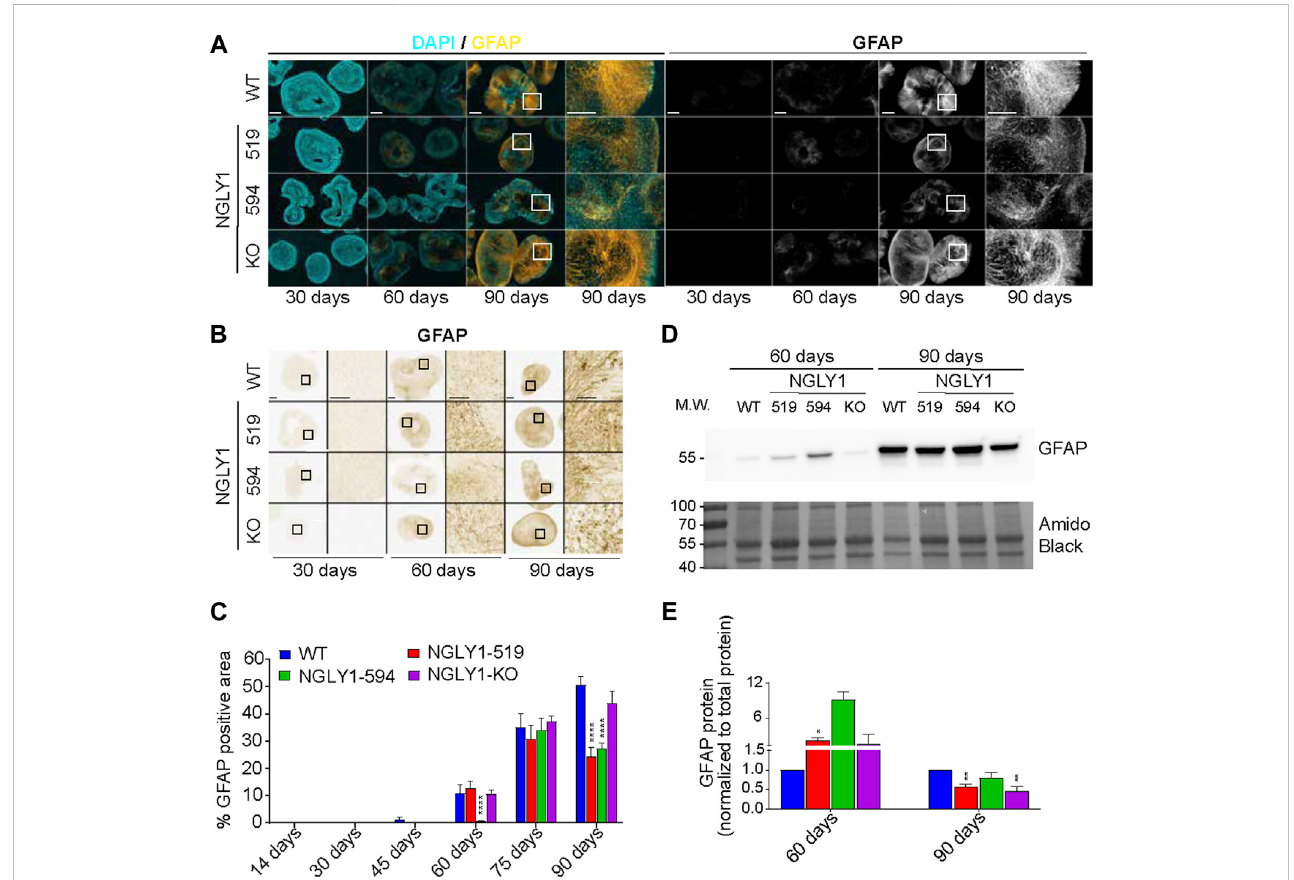
FIGURE 4 Development of astrocytes in midbrain organoids characterized by GFAP expression. (A) Representative immuno fl uorescence images at ×5 and ×20 magni fi cation showing DAPI (cyan) and GFAP (yellow). Scale bars: 250um (5x) and 50um (20x), white boxes indicate zoomed in region. (B) Representative bright fi eld images of GFAP immunohistochemistry staining at ×4 and ×20 magni fi cation. Scale bars:250um (4x) and 50um (20x), black boxes indicate zoomed in region. (C) Quanti fi cation of total percent positive GFAP staining. (D) A representative western blot showing GFAP expression in cell lysates obtained from control and NGLY1 disease midbrain organoids. (E) Quanti fi cation of GFAP protein expression normalized to total protein. Data representative of all slices derived from three midbrain organoids. Statistical signi fi cance determined bymultiple t -test analysis denoted by* = ( p ≤ 0.05), ** = ( p ≤ 0.01), *** = ( p ≤ 0.001), **** = ( p ≤